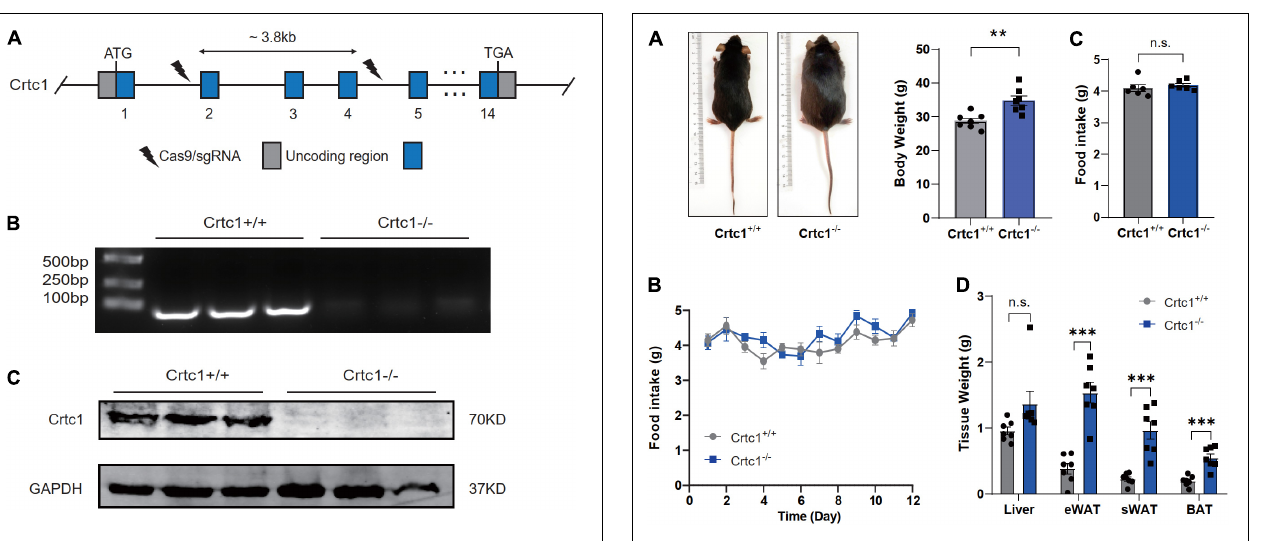
FIGURE 2 | Crtc1 deficiency induces obesity in mice. (A) Representative images of appearance of Crtc1 + / + and Crtc1 − / − mice. (B) Food intake of Crtc1 + / + and Crtc1 − / − mice during pair feeding. (C) Average body weight and daily food intake in the two groups. (D) Effect of Crtc1 deficiency on the weight of Liver, eWAT, sWAT and BAT. Data are mean ± SEM; ** P < 0.01, *** P < 0.001 and n.s. indicates no significant